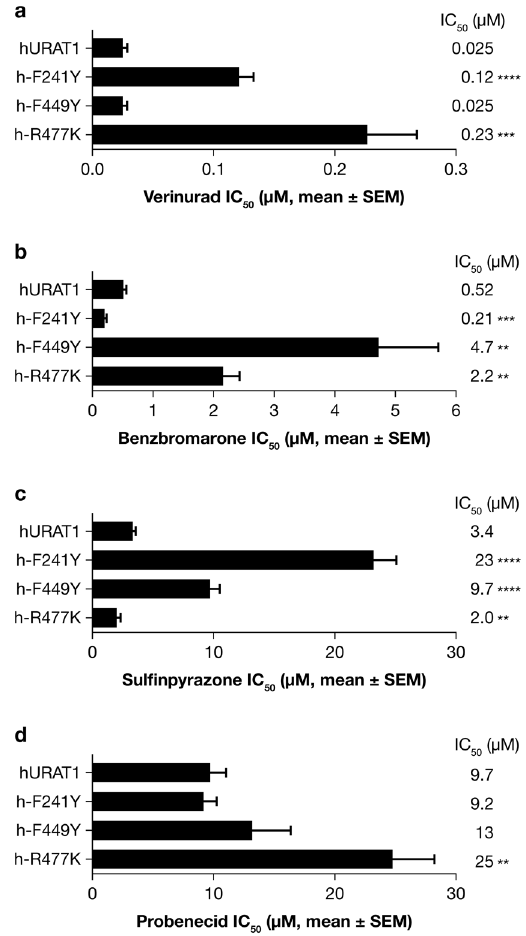
Figure 6. Each URAT1 inhibitor has a distinct profile of potencies for URAT1 mutants. Potencies of verinurad ( a ), benzbromarone ( b ), sulfinpyrazone ( c ) and probenecid ( d ) against human URAT1 (hURAT1) and hURAT1 with “binding site” point mutants F241Y, F449Y and R477K. Dose-response experiments were performed as in Fig. 3, and results are the mean ± SEM from at least three